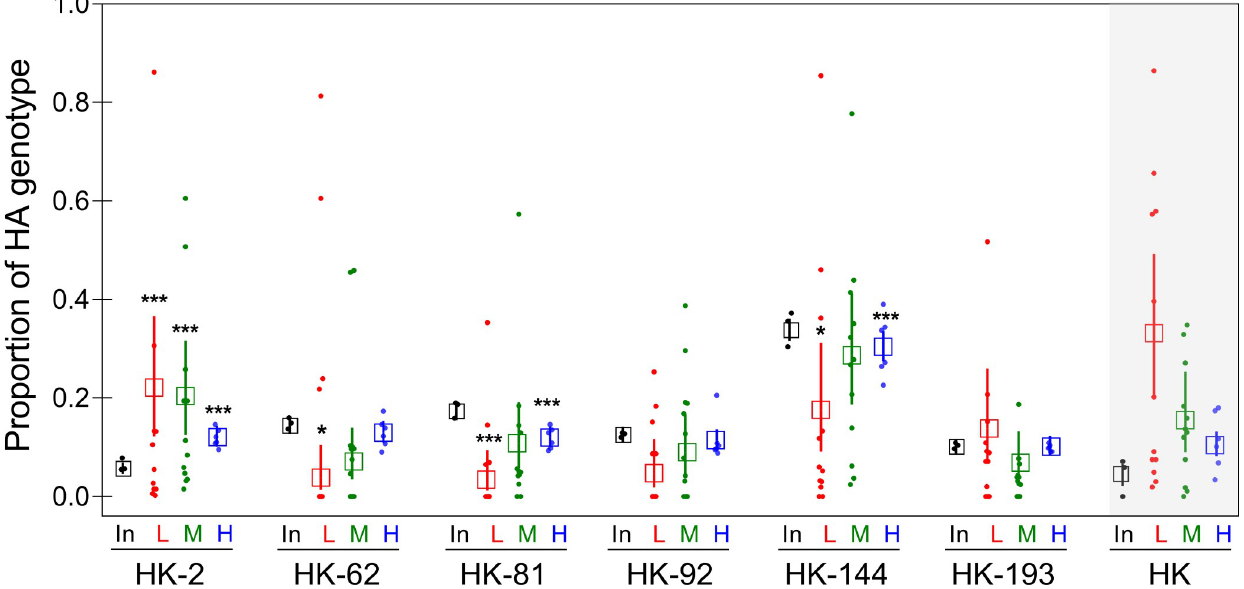
Fig 8. Competitive replication of HK and its 6 single-point HA mutants in HTBE cultures. HTBE cultures were inoculated with the mixtures of HK and its 6 HA mutants containing 5 PFU (L, 12 replicate cultures), 20 PFU (M, 12 replicates) and 320 PFU (H, 6 replicates) of each virus. After 1-h incubation, the inoculum was removed, the cultures were incubated under ALI conditions, and the apical material was harvested at 72 h post-inoculation. Small filled circles show proportions of each HA genotype determined by next generation sequencing in the inoculated mixture (In) and in each replicate harvest in the L, M and H groups. Empty squares and error bars represent the mean values and confidence intervals of proportions. Asterisks depict statistical significance of the differences between proportion of the corresponding genotype in the harvest and in the inoculum. The proportions of the parent HK virus (shown on gray background) were inferred by subtracting proportions of the six HA variants from a theoretical value of 1. Because of the high intrinsic errors of this approach the data for HK were not analysed for statistical significance.